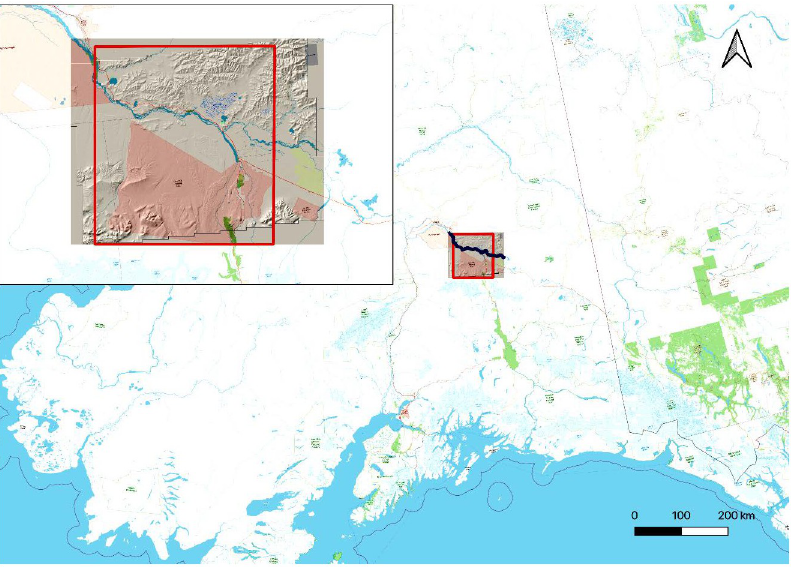
Fig 1. Location of Tanana Valley study area in Alaska. The data used to produce the background layers in this image are available under the Open Database License from OpenStreetMap.org